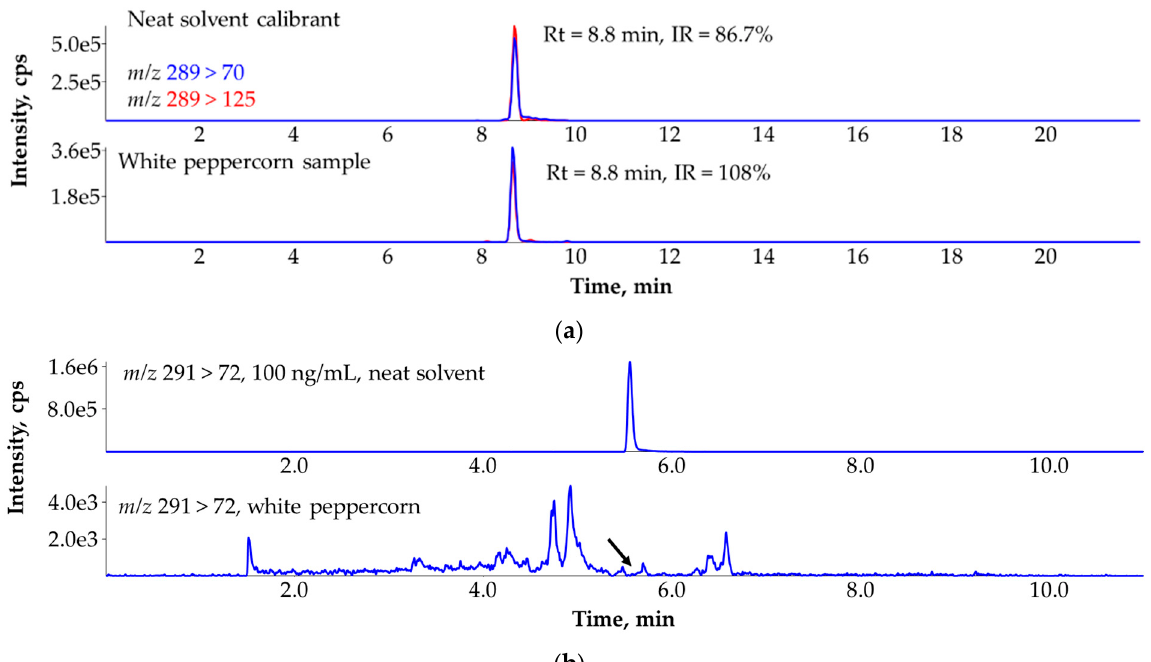
Figure 3. ( a ) Screening analysis of myclobutanil in a white peppercorn sample. The identification criteria meet the theoretical requirements, i.e., the retention times and IR in the sample (below) were within the tolerance limits determined according to the neat solvent calibrant (100 ng/mL, above). ( b ) Confirmatory analysis for myclobutanil in a white peppercorn sample. The A + 2 ion transitions